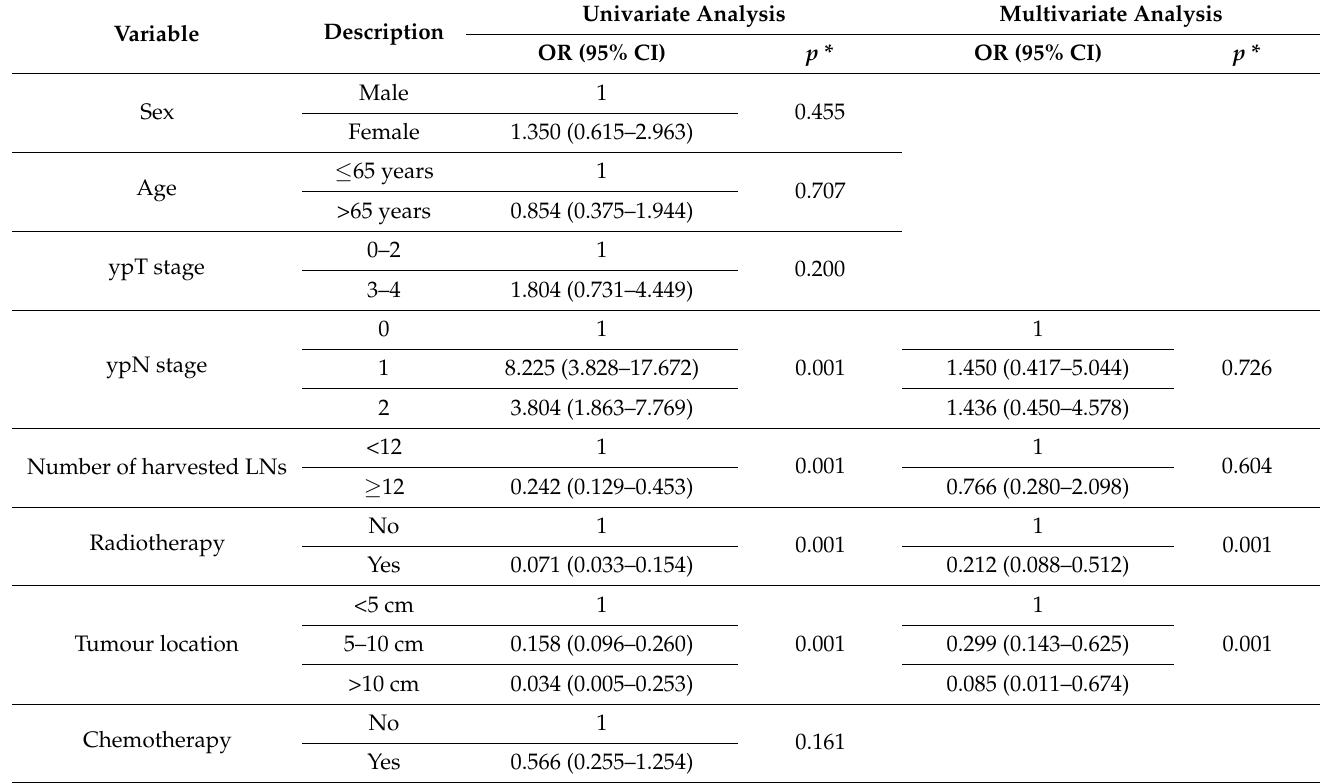
Table 4. Univariate and multivariate analysis of risk factors of local